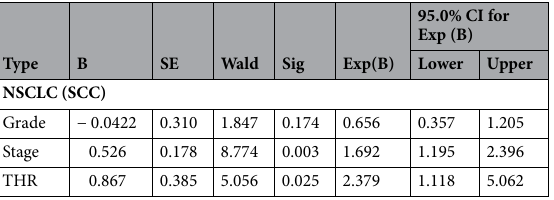
Table 5. Multivariate Cox regression analysis of relationship between clinicopathological characteristics and prognosis in NSCLC (SCC)